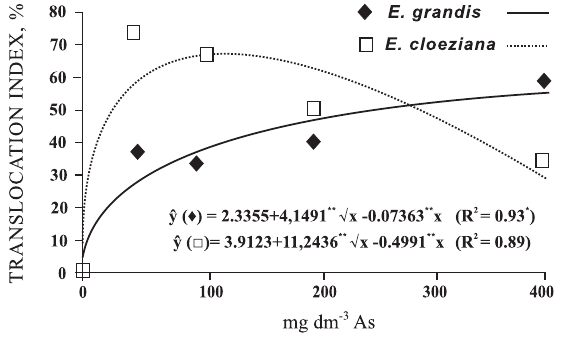
Figure 4. Translocation index of As in plants of E. grandis , E. cloeziana as a function of the As dose applied to the soil. * * and *: significant at 1 and 5 %, respectively, by the F test.